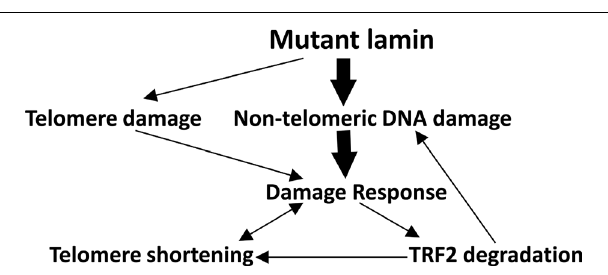
(B) Quantitation of γ -H2AX foci in indicated cell lines. Signals co-localizing TRF2 (gray) and those not co-localizing (black) are separately shown. In each condition approximately 70 cells were analyzed for each cell lines.